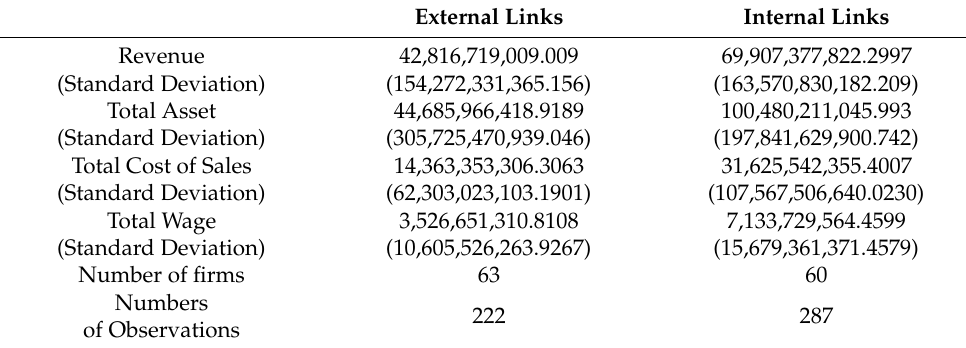
Table 1. Sample statistics.